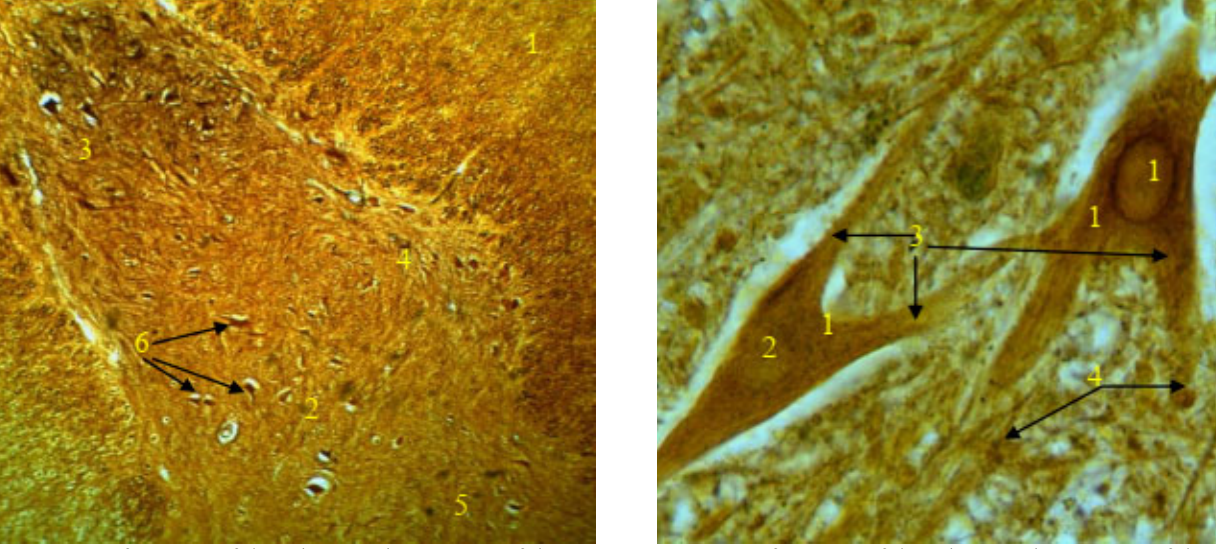
Fig. 1. A fragment of the microscopic structure of the spinal cord of mature cattle: 1 – white matter; 2 – gray matter; 3 – dorsal horn; 4 – lateral horn; 5 – ventral horn; 6 – nerve cells. Ramón-y-Cajal. × 120 The spinal cord's dorsal horns in cattle are represented, for the most part, by small neurons with barely visible pro- cesses. There are also single nerve cells of large size with pronounced processes and the presence of rounded nuclei, which are located